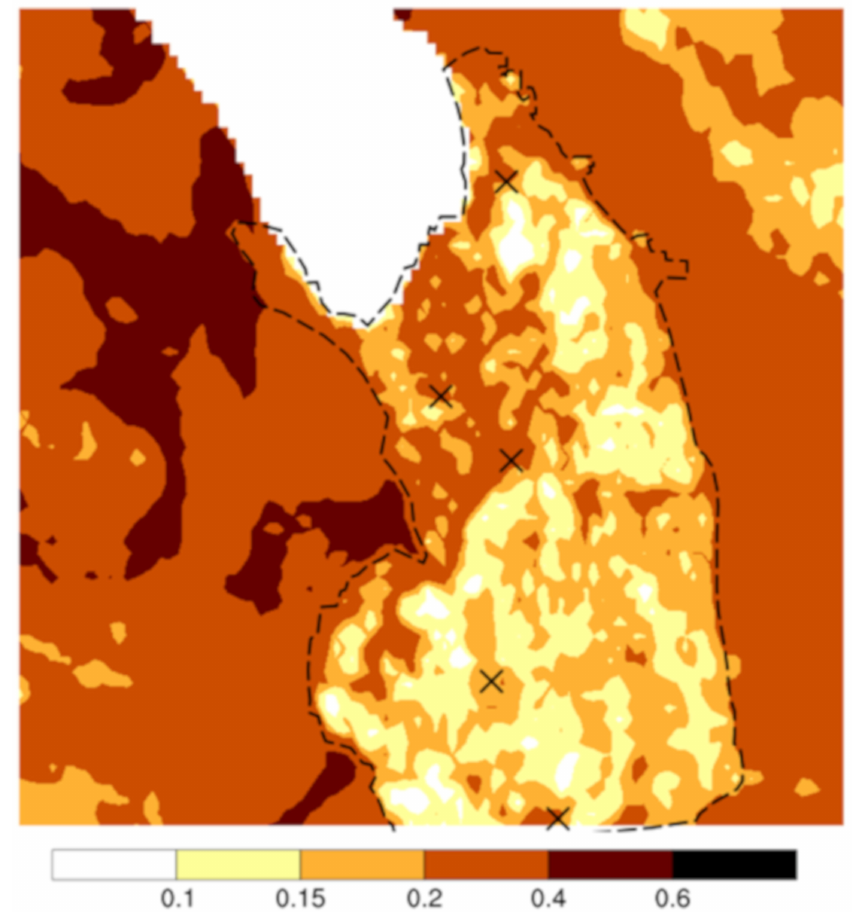
Figure 7. Sediment supply fields over the Imperial Valley and surrounding area from the 500 m global dataset developed by Parajuli and Zender [24]. Field regridded to 1 km to be consistent with the MAIAC AOD fields. The dashed line is as Figure 6, and the ”x” symbols indicate locations of routine PM monitors (see Figure